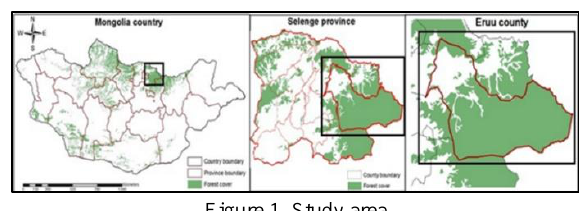
Figure 1. Study area